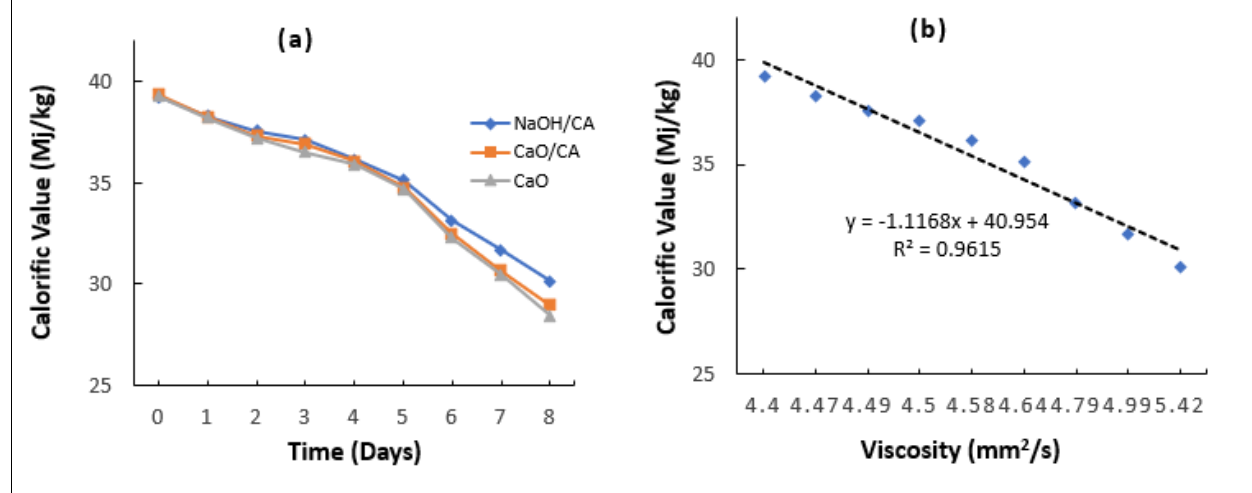
Figure 13. Physical properties of oxidized biodiesel: ( a ) calorific value and ( b ) correlation between calorific value and viscosity of B100 from BSFL.